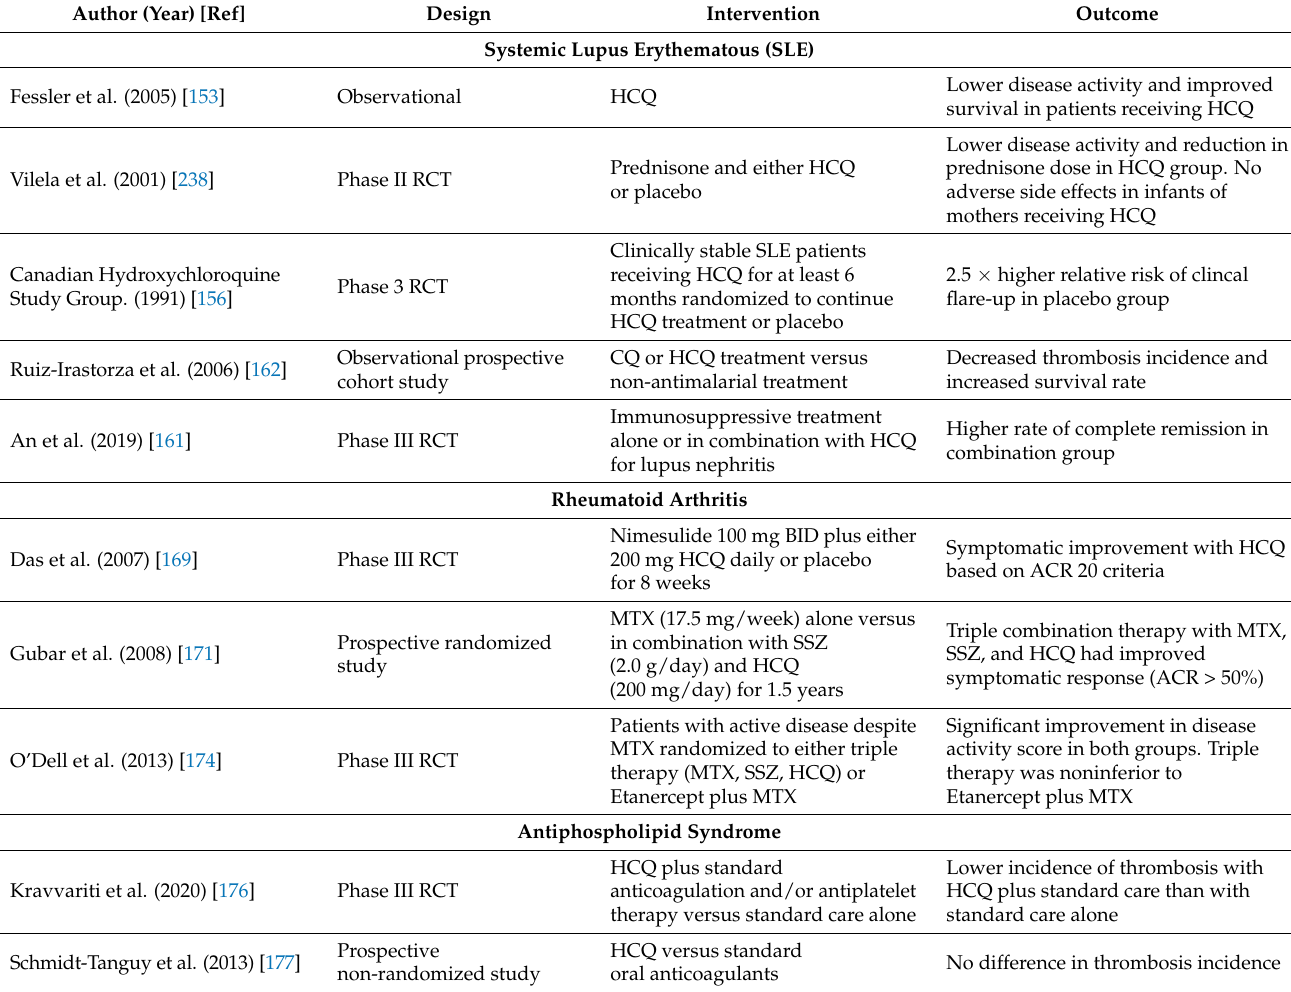
Table 1. Review of clinical trials evaluating CQ and HCQ in human